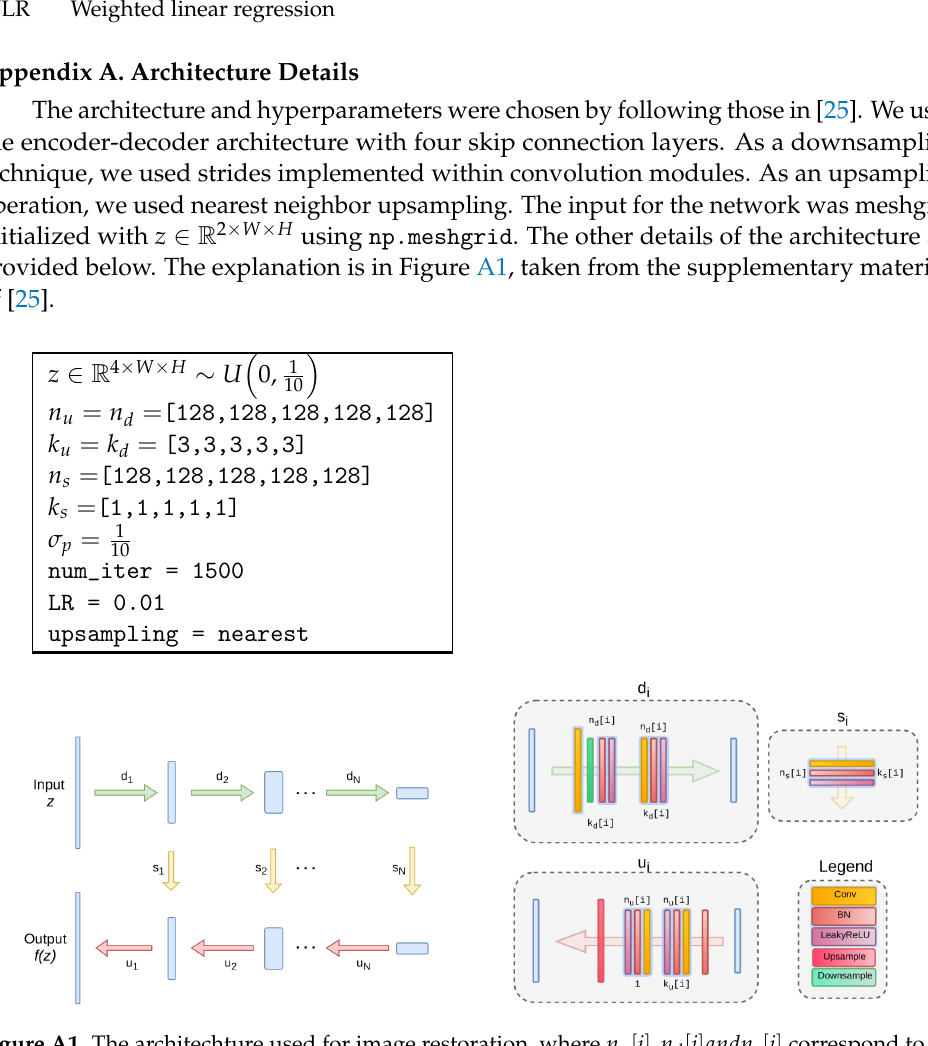
Figure A1. The architechture used for image restoration, where n u [ i ] , n d [ i ] andn s [ i ] correspond to the number of filters at depth i for the upsampling, downsampling and skip connections, respectively. The values k u [ i ] , k d [ i ] andk s [ i ] correspond to the respective kernel sizes. The image were taken from the suplemantary materials in